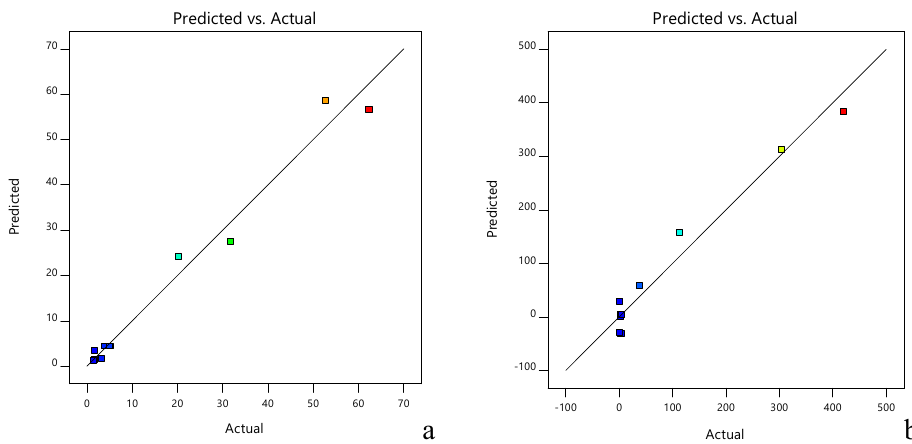
Figure 3. Predicted versus actual values for HMF ( a ) and ACR ( b ) content of sea buckthorn.